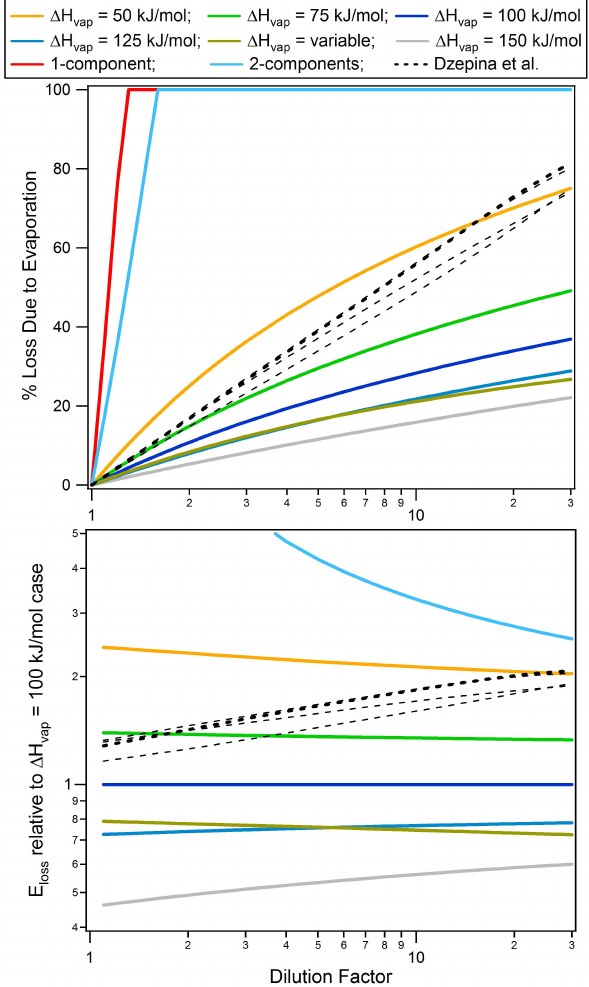
Fig. 3. (top) The E loss , or the additional mass loss due to evap- oration after dilution, is shown as a function of the dilution fac- tor for the various 1H vap cases (see legend; colors correspond to Fig. 2). The dashed lines correspond to the results when the Dzepina et al. (2009) volatility distributions are used; the thick line is for the 02:00p.m. case and the thin lines are for other times. (bot- tom) The various E loss are shown relative to that calculated for the 1H vap =100kJ/mol